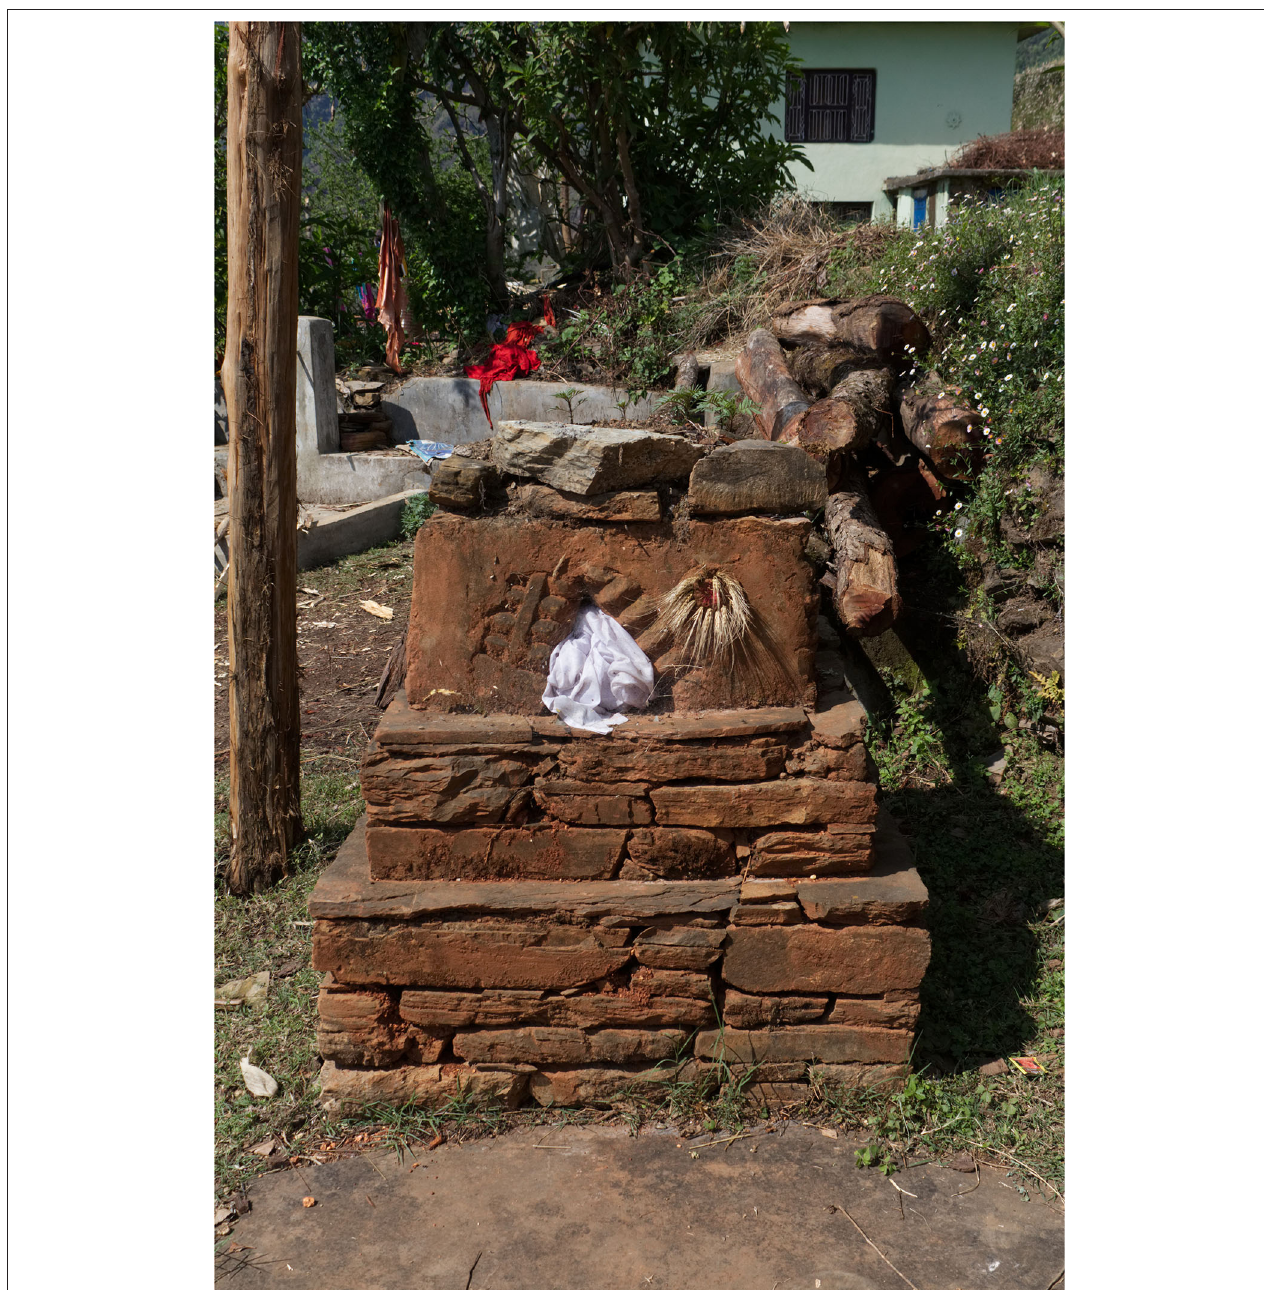
FIGURE 9 | A typical tulsi shrine in a yard in